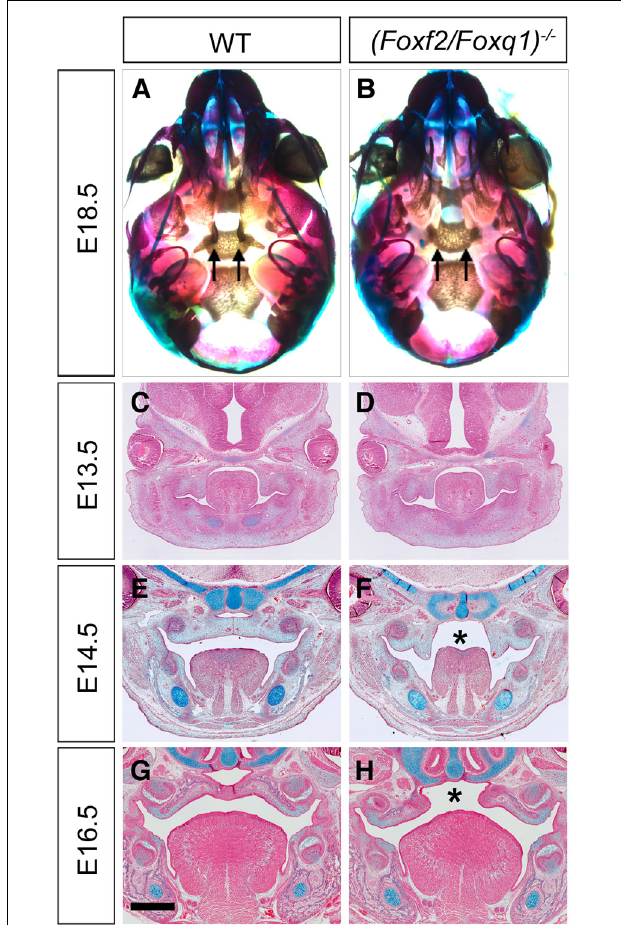
FIGURE 4 | Phenotypical analysis of palate developmental defects in (Foxf2/Foxq1) − / − mutant mouse embryos. (A) Skeletal preparations of heads of E18.5 wildtype (WT) (A) and (Foxf2/Foxq1) − / − (B) embryos. Note that the pterygoid processes (arrows) were extremely hypoplastic in (Foxf2/Foxq1) − / − (B) compare with WT (A) embryos. (C–H) Representative frontal sections of wildtype (C,E,G) and (Foxf2/Foxq1) − / − (D,F,H) embryos at E13.5 (C,D) , E14.5 (E,F) , and E16.5 (G,H) . Note that (Foxf2/Foxq1) − / − embryos displayed cleft palate (“*” in F and H marks the gap between the bilateral palatal shelves). Scale bar, 500 µ